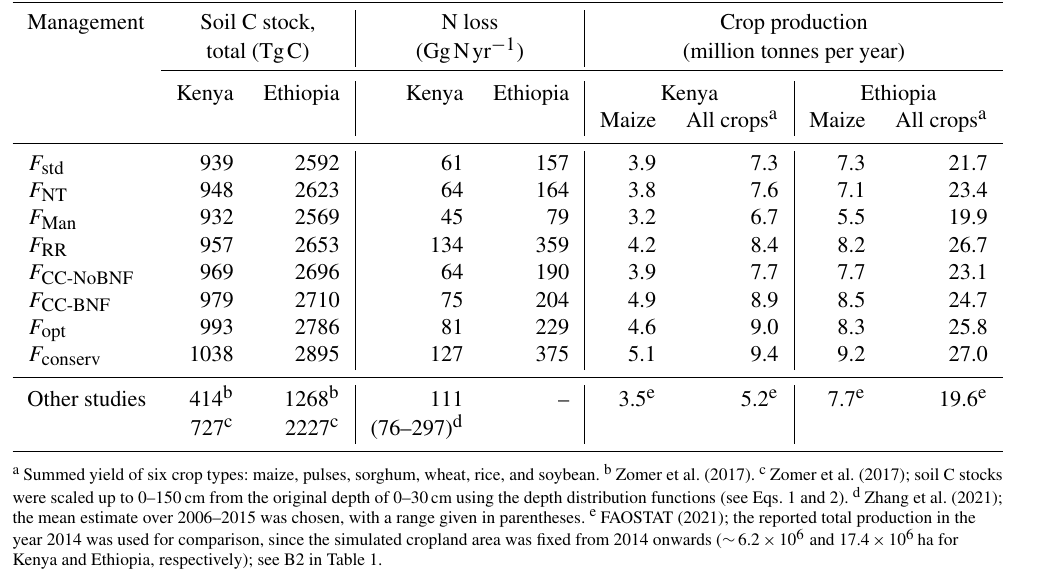
Table 5. Modelled total cropland soil C stocks (0–150cm), N loss, and total crop production with different management options in Kenya and Ethiopia, compared to literature-based estimates. See Table 3 for abbreviations.